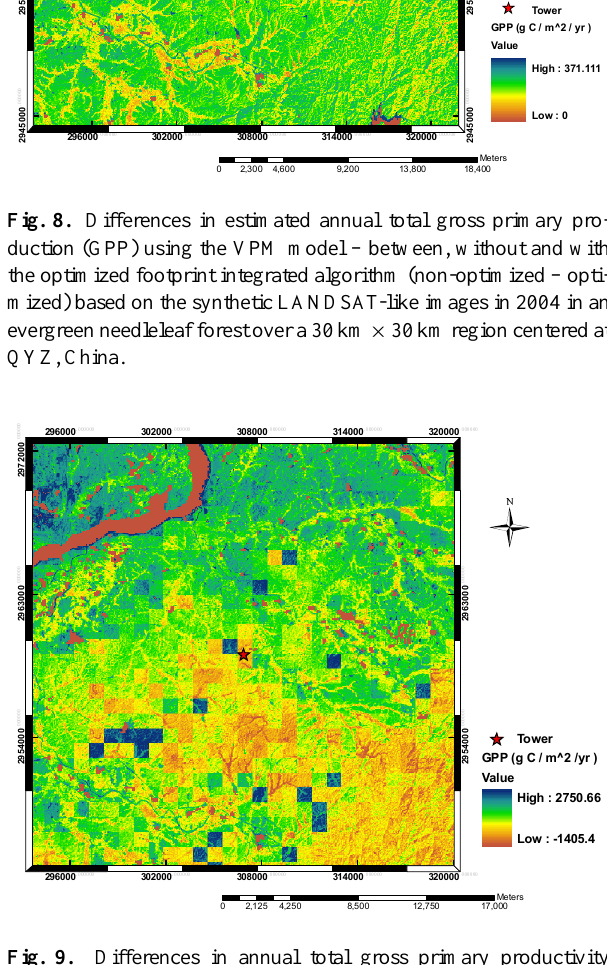
Fig. 7. A comparison of the seasonal dynamics between the ob- served and remotely sensed gross primary productivity (GPP) in 2004 in an evergreen needleleaf forest at QYZ, China. The inset shows the cumulative curves of the five estimations of GPP from the beginning to the end of the year 2004.